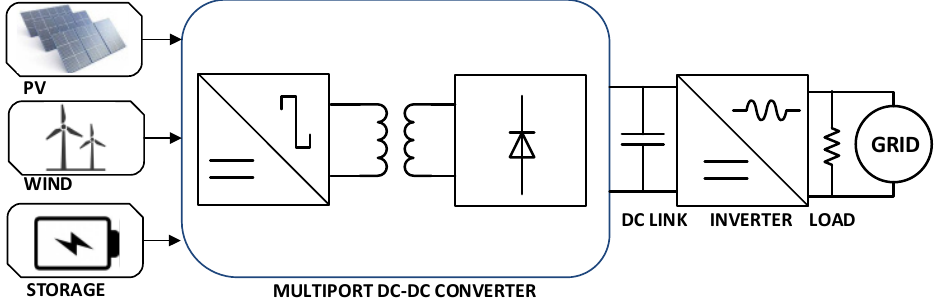
Figure 1. Structure of a double stage MPC system connected to a distribution grid line.